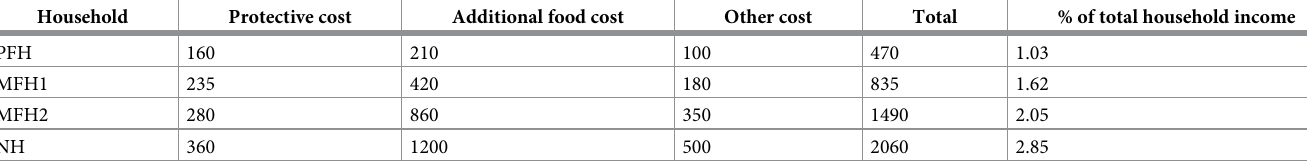
Table 3. Additional costs of rural households deriving from COVID-19 epidemic (RMB). Household